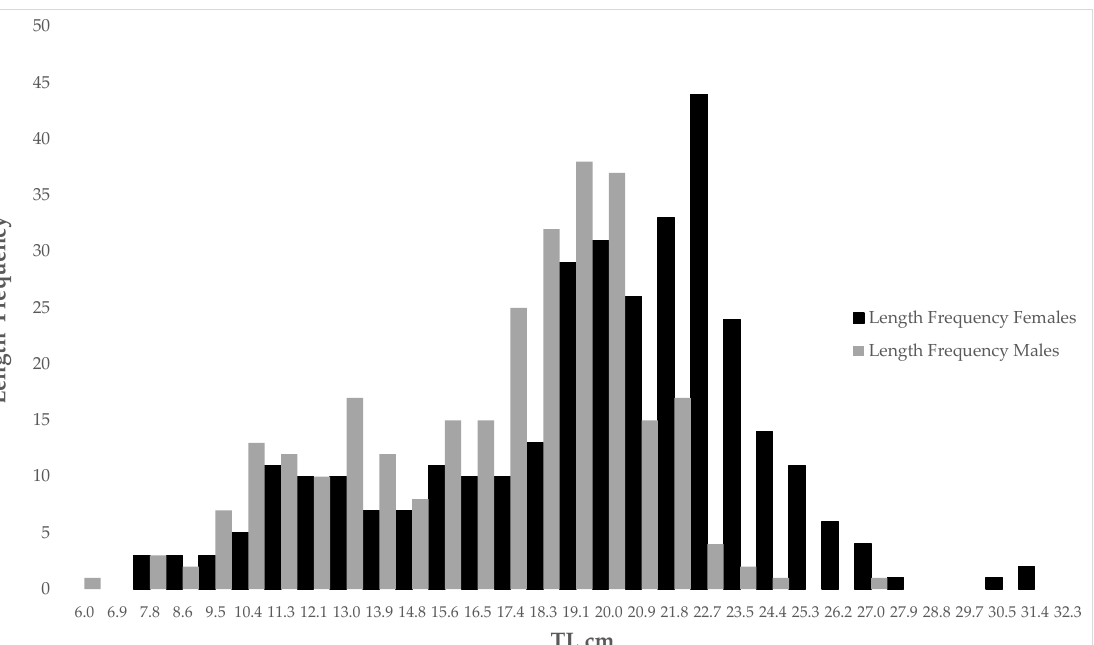
Figure 2. Length frequency of males and females U. chilensis in the SGC.